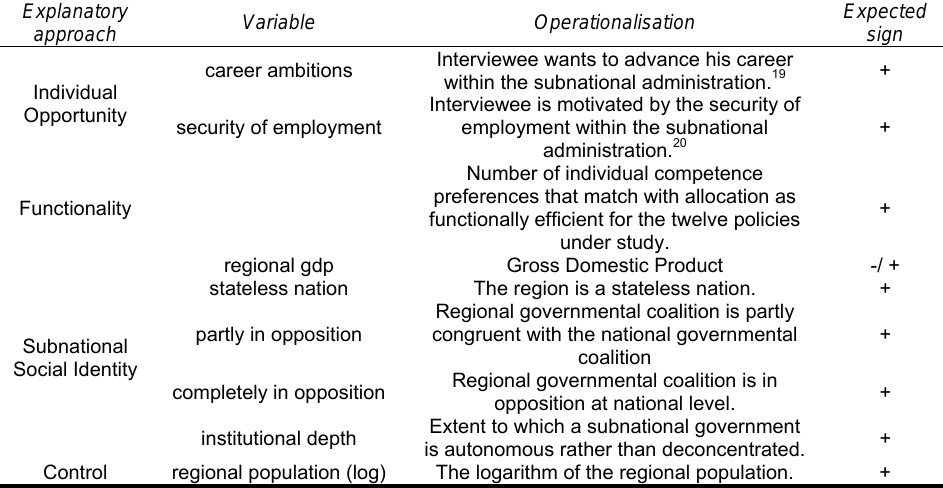
Table 3: Operationalisation of the explanatory variables Explanatory